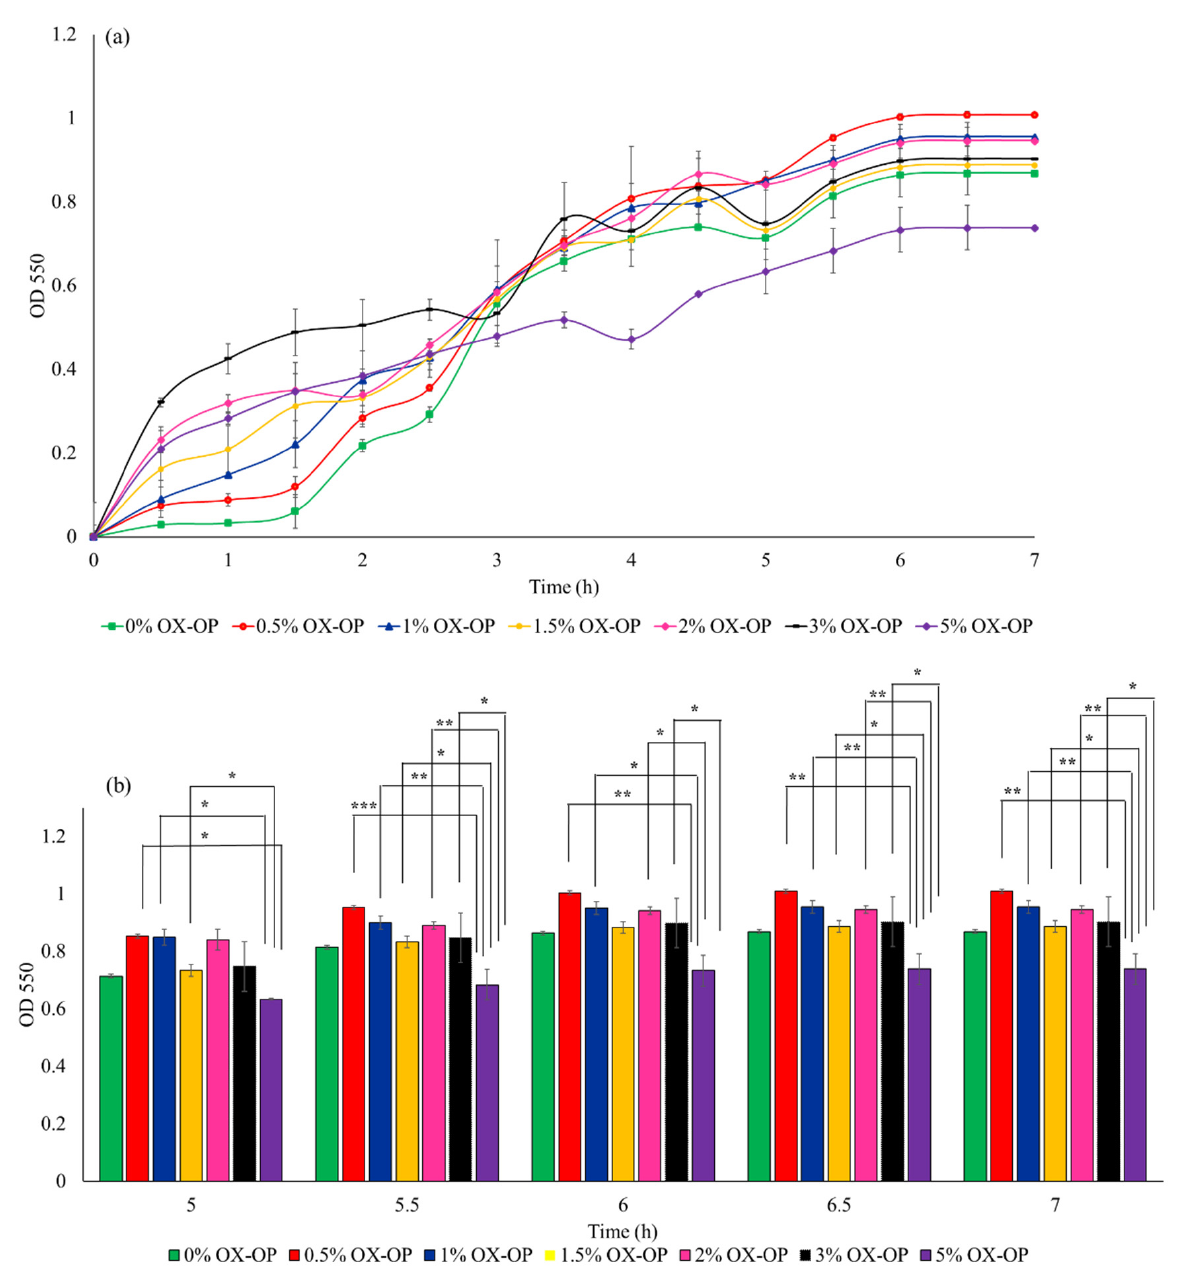
Figure 6. ( a ) Growth rate of JM109 E. coli in the presence of oxidized orange peel liquor (OX-OP). ( b ) Statistical analysis of growth rates by two-way ANOVA, (* p < 0.05, ** p < 0.01, *** p < 0.001). In addition, to study the suitability of acid hydrolyzed orange peel liquor as a carbon source and to compare the acid hydrolyzed orange peel with oxidized samples, a cell viability study was carried out (Figure 7). It was noted that a high concentration (3 w / v %) of the acid hydrolyzed orange peel caused a 50% drop in bacteria growth due to the existence of inhibitory compounds and